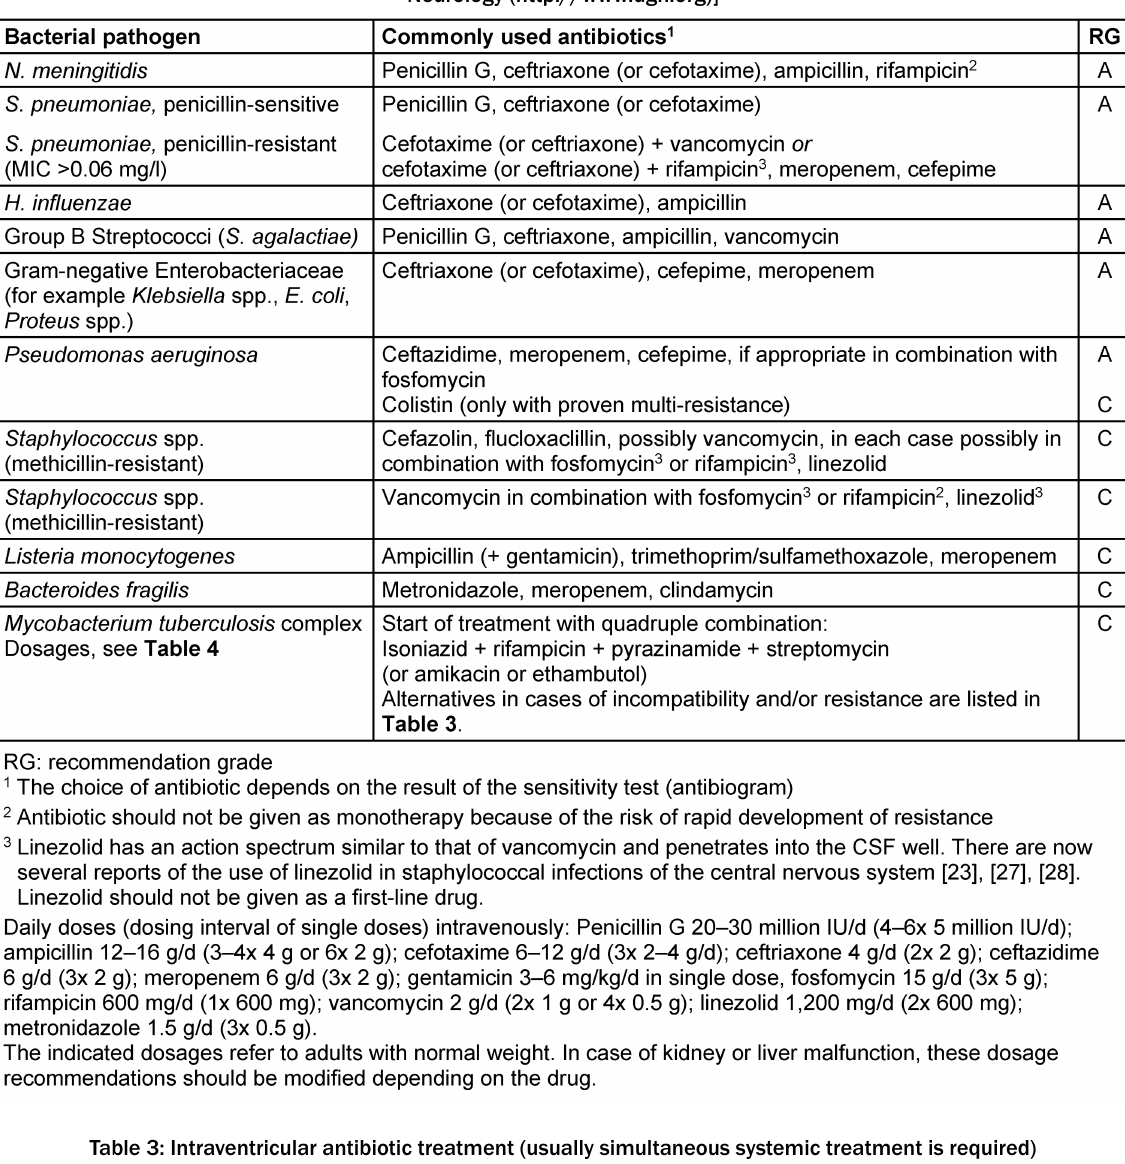
Table 2: Targeted antibiotic treatment of bacterial meningitis in adults [according to guidelines of the German Society of